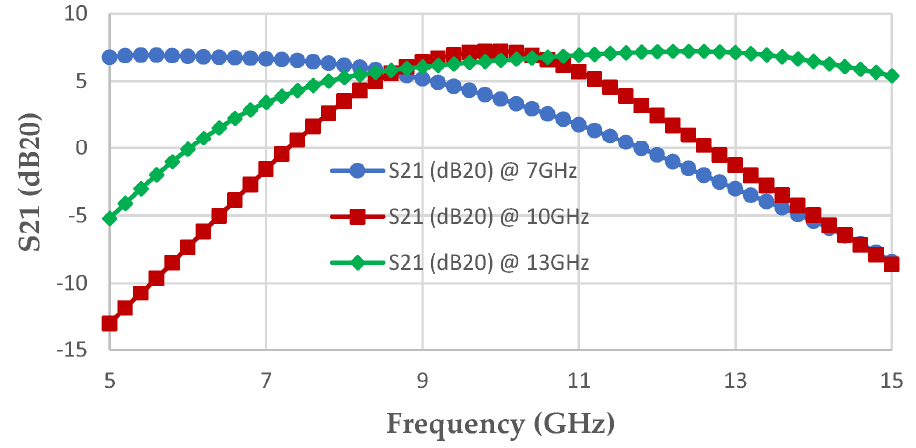
Figure 13. Simulated S21 versus frequency at 7 GHz, 10 GHz, and 13 GHz.